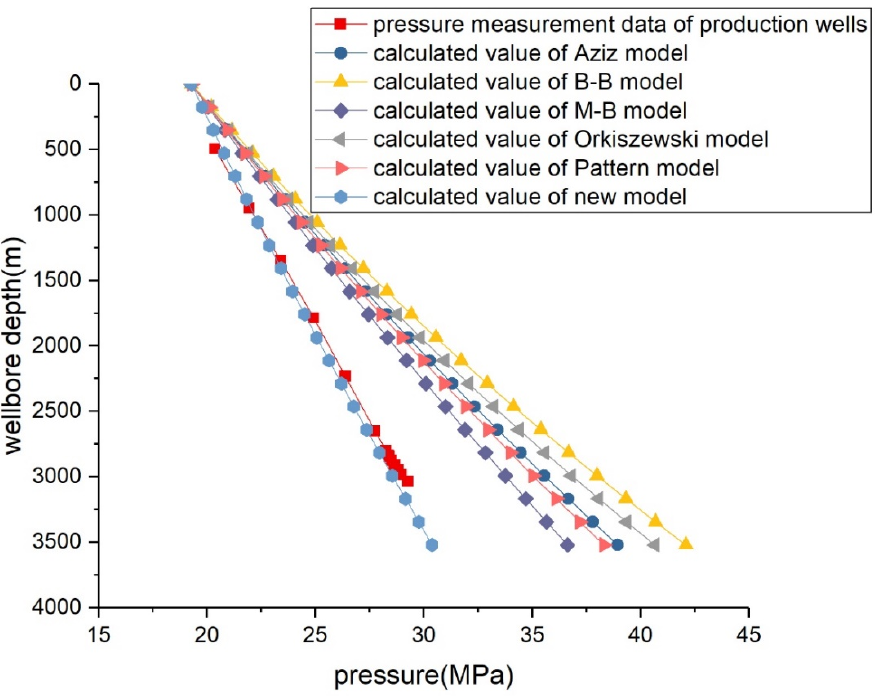
Figure 22. Different pressure calculation methods applied to the No. 2 well of the Donghai gas field.